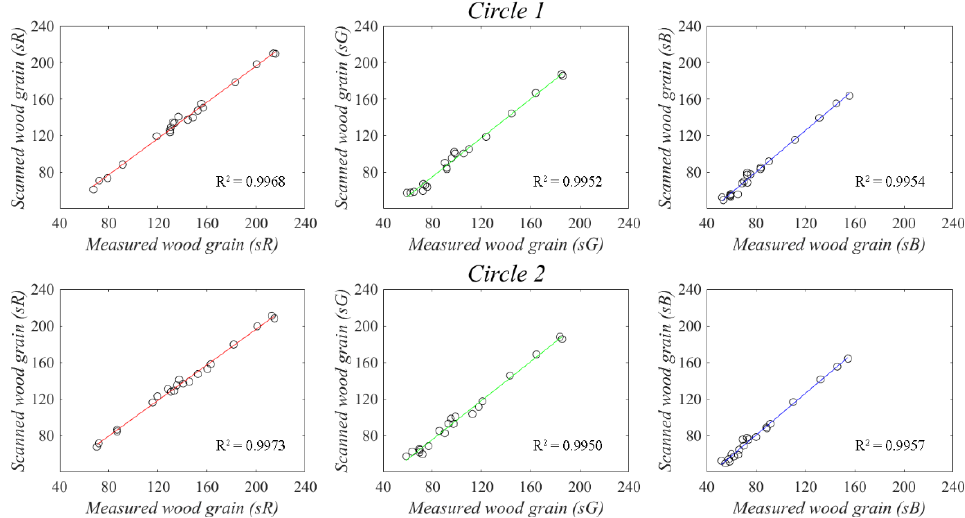
Figure 3. Correlation of the sR , sG , and sB values of the twenty kinds of wood specimens obtained from the 8 mm circles on the measured surfaces and those on the scanned surfaces, respectively.